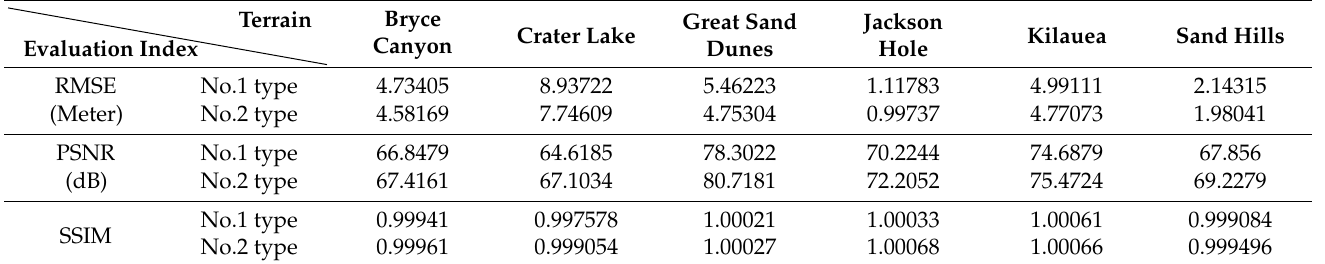
Table 4. Evaluation index of SR-DEM with different types of training datasets ( m = 500, δ =